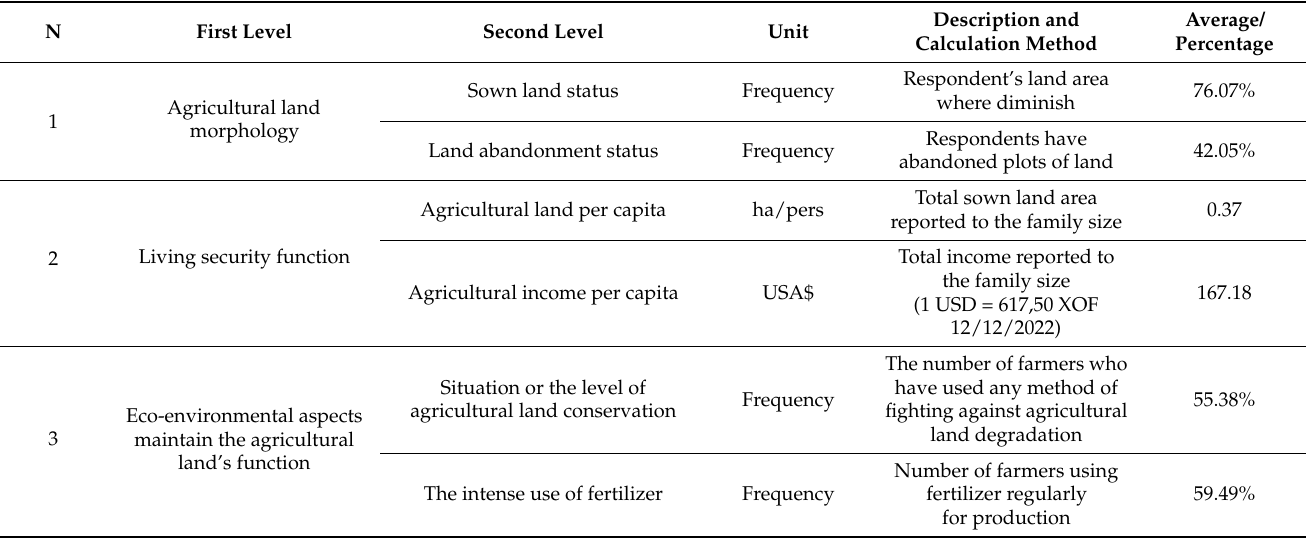
in Table 4: x i = Explanation variables. This study referred to the variables in Table 3: β θ = y-intercept (constant term); β p = slop coefficients for each explanatory variable; ∈ = the model’s error term (also known as the residuals). Table 4. The evaluation indexes of agricultural land use functions (Survey data, October